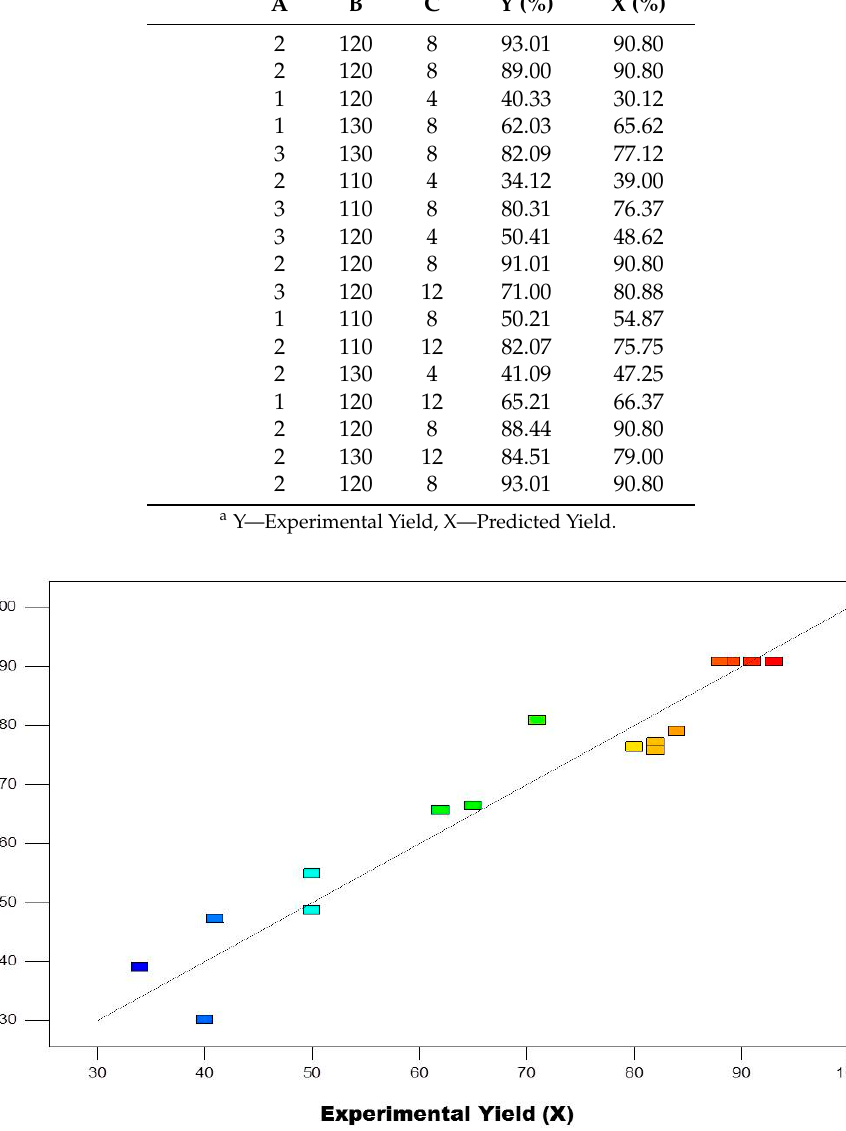
Figure 2. The predicted and actual isolated yield values.